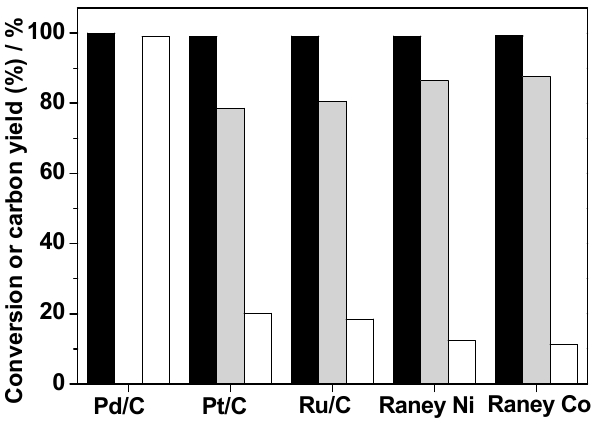
Figure 4. Cyclopentanone conversions (black columns) and carbon yields of 2,5-bis(2-furylmethylidene)-cyclopentanone (gray columns), and 2,5-bis(furan-2-ylmethyl)-cyclopentanone (white columns) over CaO and metal catalysts. Experimental conditions: 10 h, 423 K, and 4.0 MPa H 2 ; 0.84 g cyclopentanone (10 mmol), 1.92 g furfural (20 mmol), 0.05 g CaO and 0.05 g metal catalyst were used in the tests.